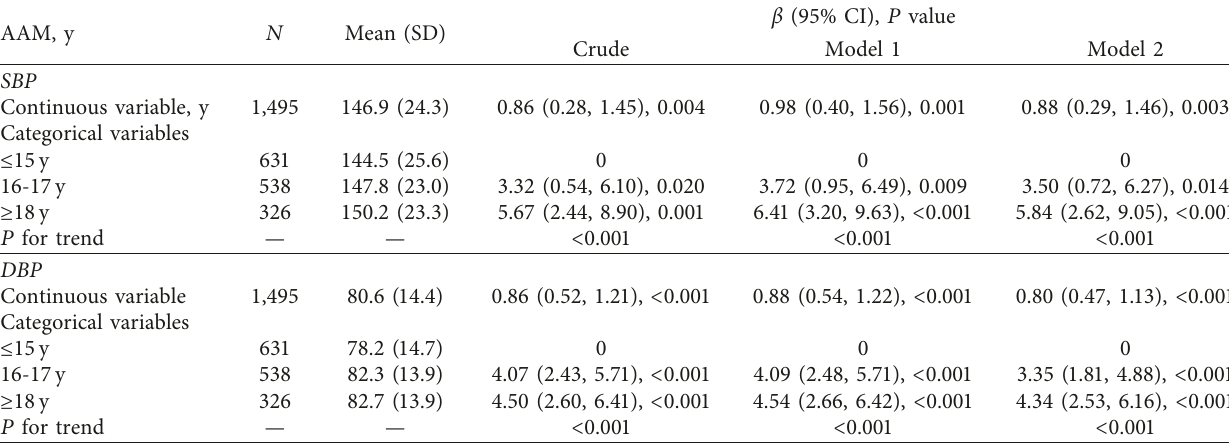
Figure 2: Multivariate adjusted smooth curve of hypertension by AAM. The solid line represents the estimated values, and the dashed line represents the 95% CI. Adjusted for enrollment age, residence, education, marital status, smoking, drinking, menopause, antihypertensive medication, physical activity, BMI, WC, BFP, VAI, BMR, HR, and sleeping duration. Table 3: Analysis of AAM and SBP, and DBP in females with